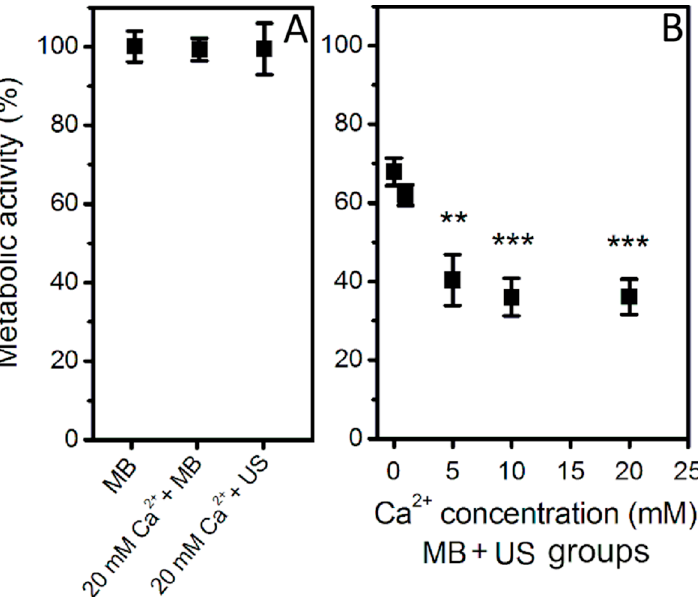
Figure 6. Cell metabolic activity (MTT assay after 48 h), evaluated after US (400 kPa) treatment in the presence of MBs at different Ca 2+ concentration. (MB), (Ca 2+ + MB) and (Ca 2+ + US) experimental groups ( A ); (Ca 2+ + MB + US) experimental groups ( B ). ** p < 0.01, *** p < 0.001 indicate statistical significance between cavitation [(Ca 2+ + MB +US) at 0 mM Ca 2+ concentration] and therapeutic [(Ca 2+ + MB +US) at 1–20 mM Ca 2+ concentration] groups. 5). PI was added at a different time after SP: 20 min, 1 h, 2 h, and 3 h. The experimental